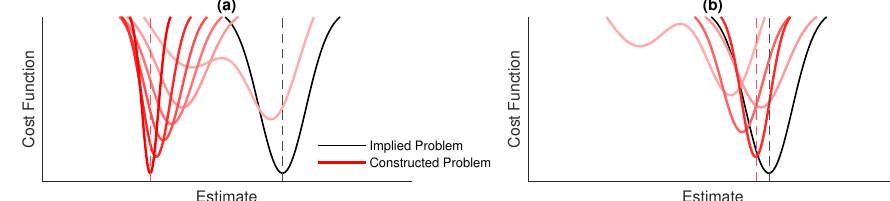
A simplified illustration of the dynamic cost functions considered in this work: the constructed problem is designed to be a good match to the implied problem , so that the minimum of the implied problem can be approximately found. However, the constructed cost function is dynamic and changes as the optimization progresses. Illustrated are ( a ) the cost function diverging from the implied function and ( b ) the cost function converging towards a good approximation to the implied